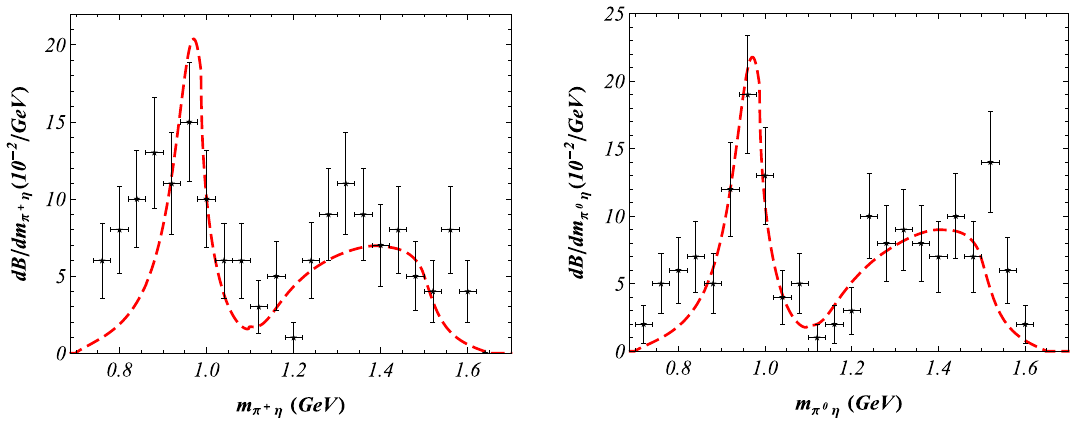
Fig. 4 The partial distributions vs. m πη , where the solid line is for A ρ only, while the dashed line receive the contributions from A ρ and A ( (cid:3) ) comparison with the data points in [7]